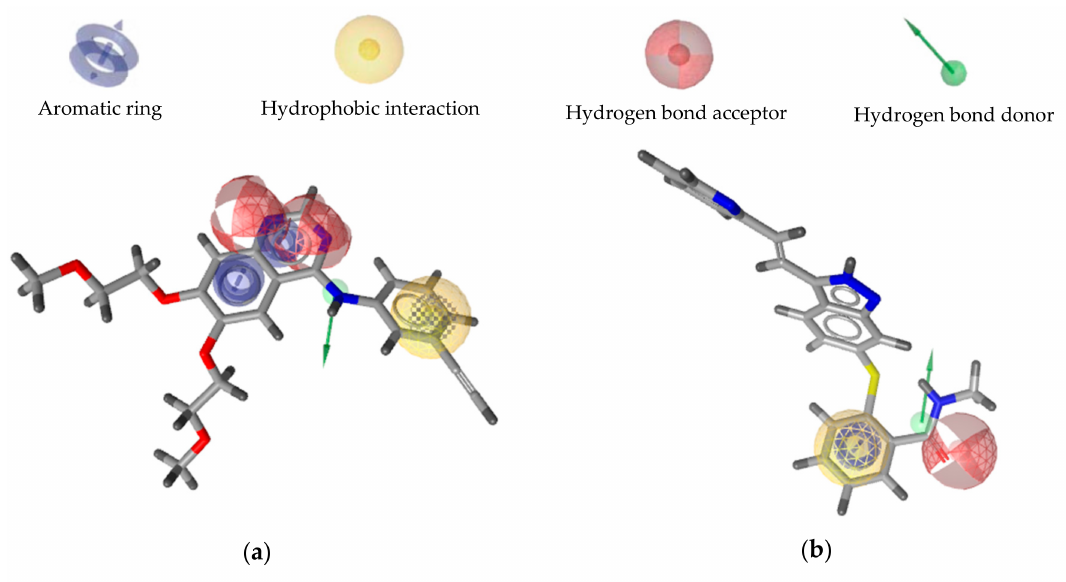
Figure 2. Overlay of erlotinib ( a ) and axitinib ( b ) on the selected pharmacophore model of EGFR and VEGFR2 inhibitor,